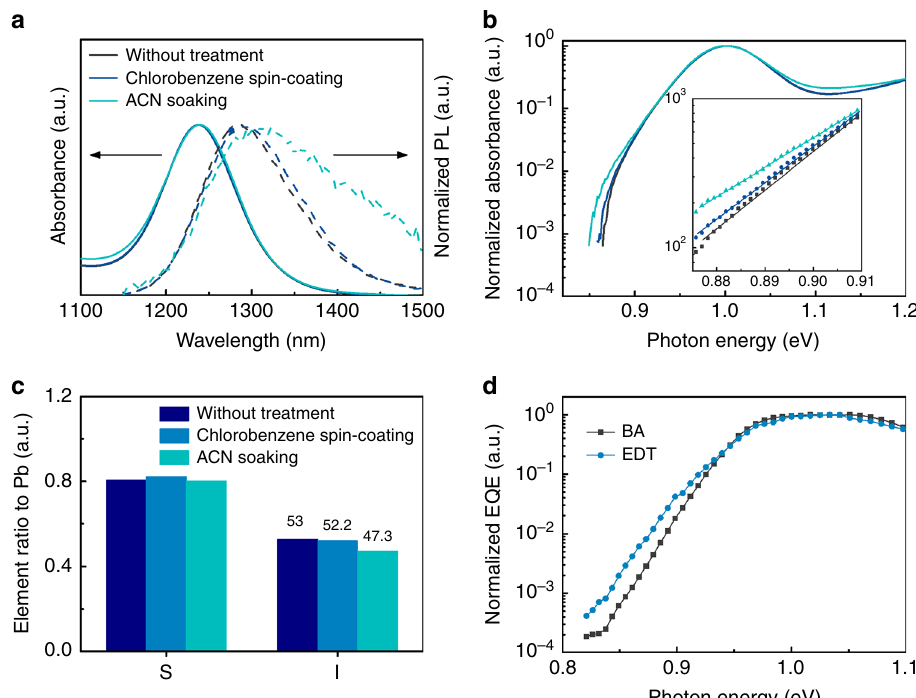
Fig. 3 Degradation of light-absorbing layer upon the application of HTL-deposition protocols. a Normalized absorption and PL spectra of CQD fi lms before and after solvent treatments. b Logarithmic-scale absorption spectra of CQD fi lms to investigate bandtail absorption. c Element ratio-to-lead of CQD fi lms before and after solvent treatments. d HDR EQE measurement of devices with BA HTL and EDT HTL to investigate the carrier distribution over the energy range below the PCE compared to devices with CH 3 -BA and EDT as seen in Fig. 4c. Speci fi cally, the Si- fi ltered PCE was 1.4 ± 0.02% for BA devices compared to 1.28 ± 0.02% for CH3-BA and 1.28 ± 0.02%